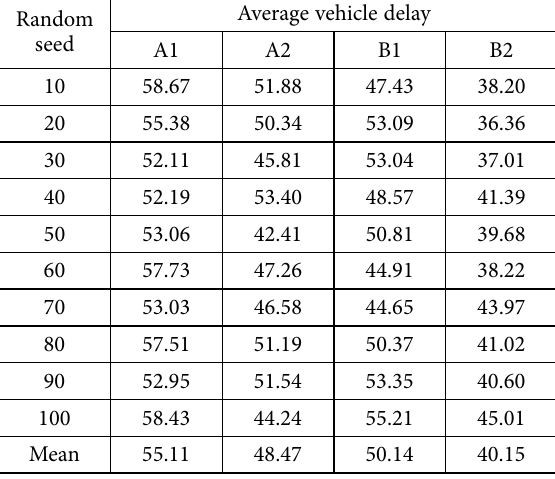
Table 2. Simulation results of the four scenarios Random seed